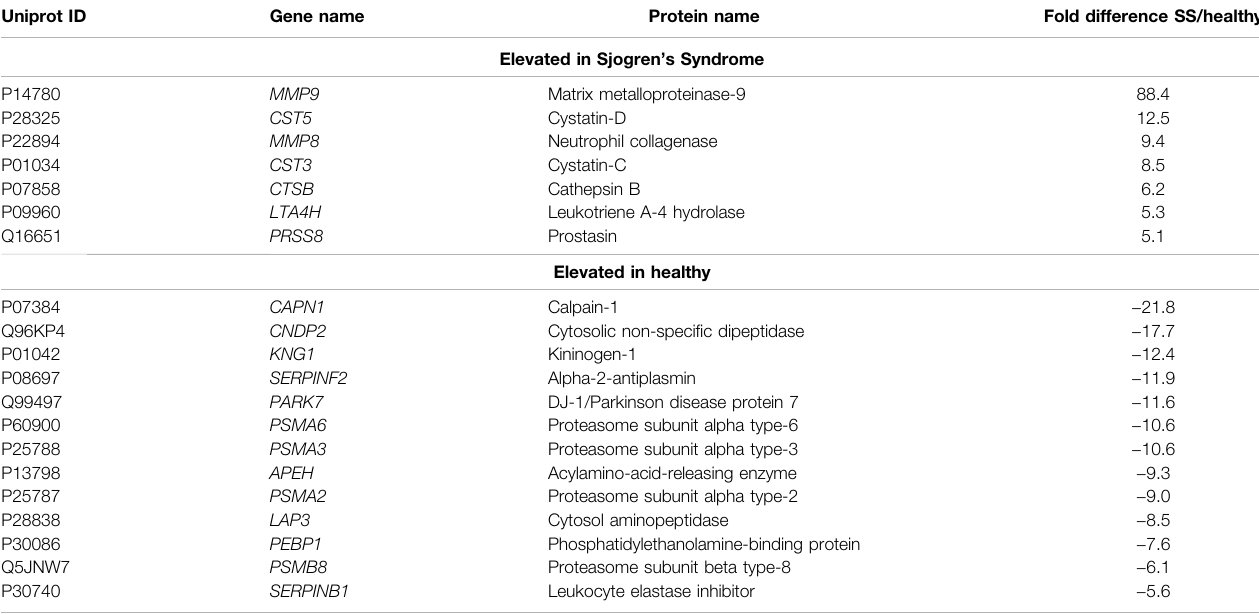
TABLE 2 | Proteases and protease inhibitors signi fi cantly elevated in Sjogren ’ s Syndrome (SS) tear wash over healthy controls. Uniprot